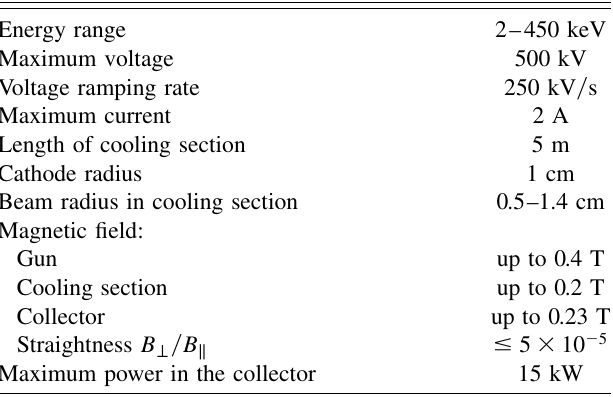
FIG. 5. (Color) Simulations of electron cooling of a coasting beam of 10 8 132 Sn 50 (cid:7) ions at 740 MeV =u . The initial beam parameters correspond to the precooled beam from CR. Electron beam density: 3 : 2 (cid:2) 10 8 cm (cid:1) 3 (1 A, 5 mm beam radius). Magnetic field in the cooling section: B (cid:4) 0 : 2